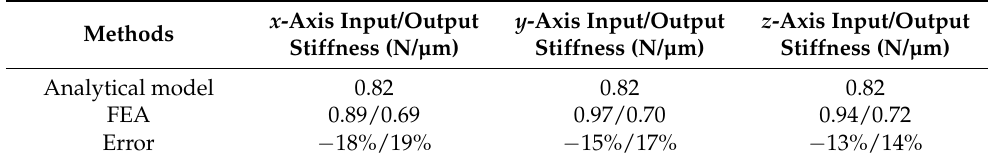
Figure 8. The correlation between input force and output displacement. Table 2. Comparison results of input